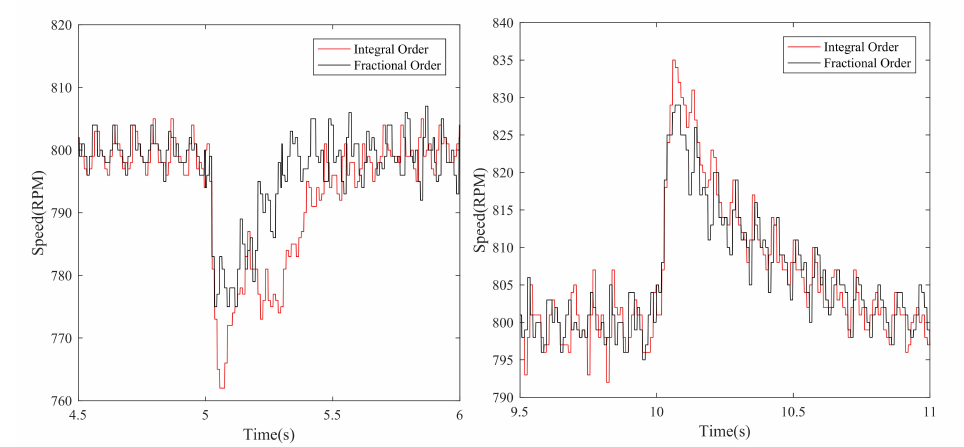
Figure 13. The speed curves with disturbance at high